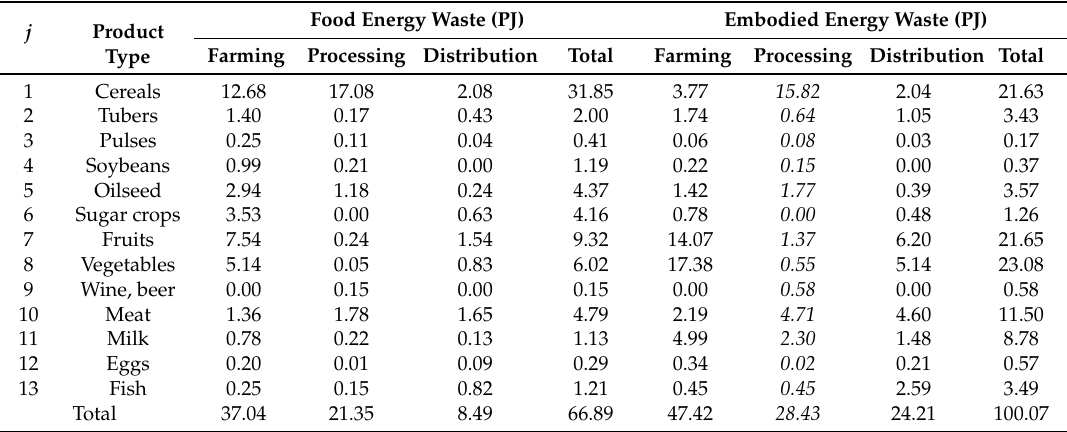
Table A4. Food energy waste and embodied energy waste for the Italian food chain.